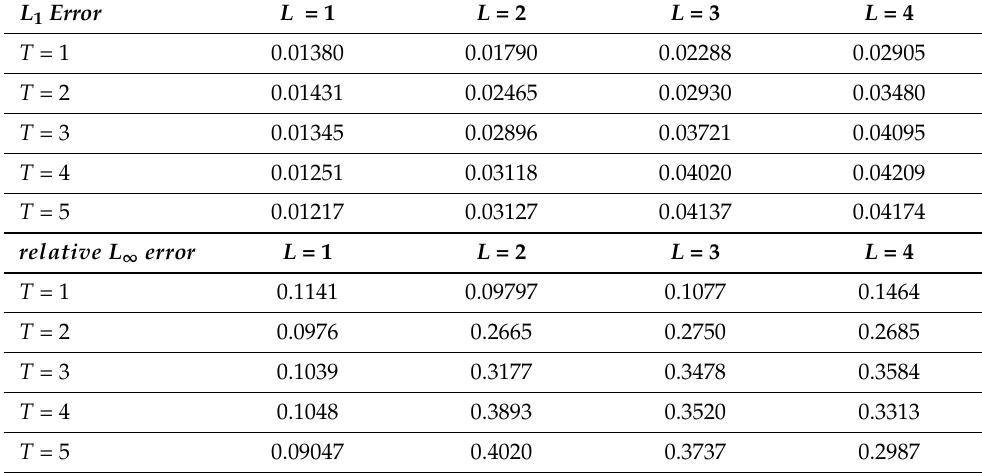
Table 6. The relative L 1 error and the relative L ∞ error in multistep